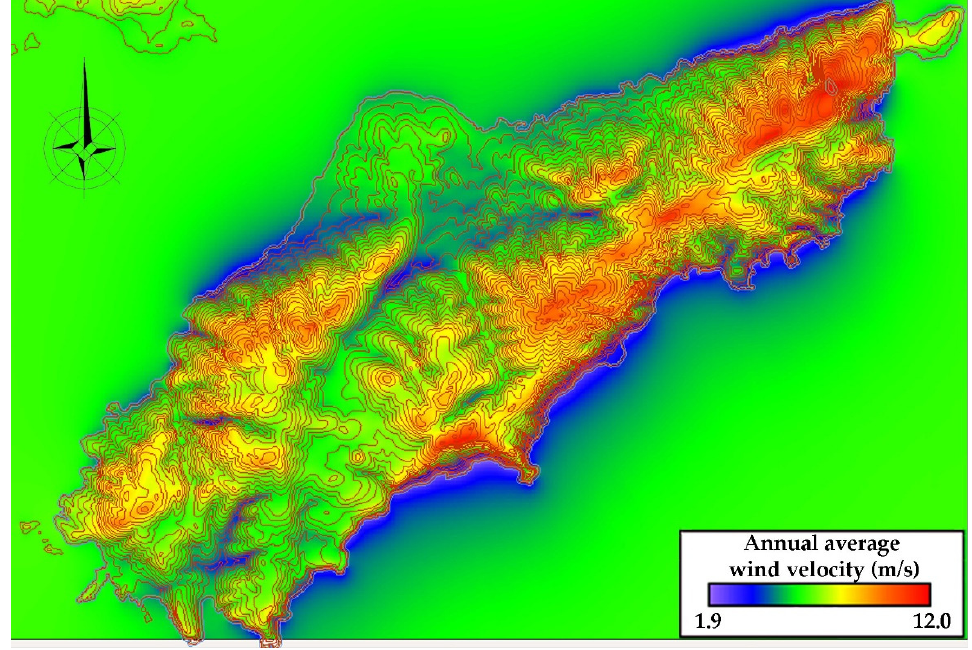
Figure 4. Annual average wind velocity map for the island of Kassos. Table 1. Licensed projects for electricity production from RES and for energy storage on March 2022, according to the Greek Regulatory Authority of Energy (RAE)